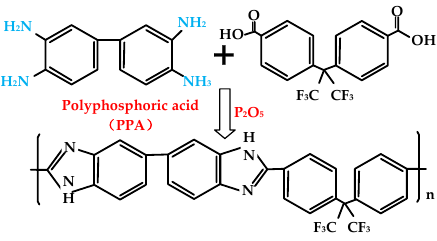
Figure 7. Synthesis process of 6FPBI.